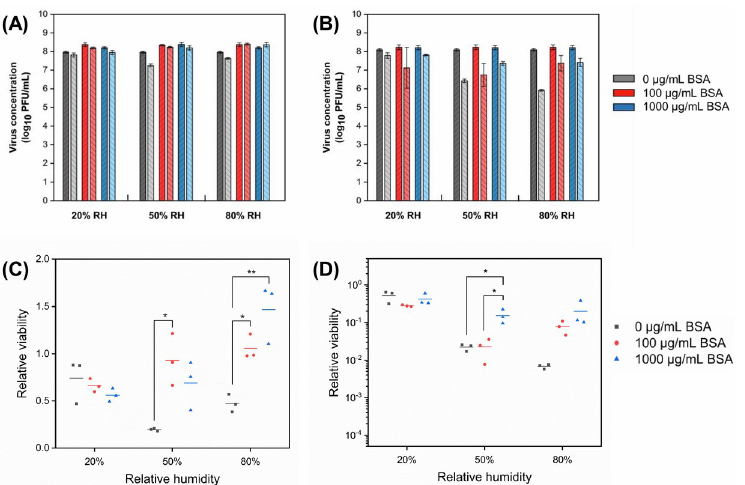
Fig 4. Concentration of bacteriophages (A) MS2 and (B) F 6 in droplets with different initial protein concentration before (dark bars) and after (light bars) 1 h exposure to low, intermediate, and high RH (mean ± s.d. of triplicates). Relative viability of (C) MS2 and (D) F 6 after 1 h exposure (lines show the mean of triplicates). The number of virions in droplets at the start of the exposure experiments was 10 5 − 10 6 PFU.